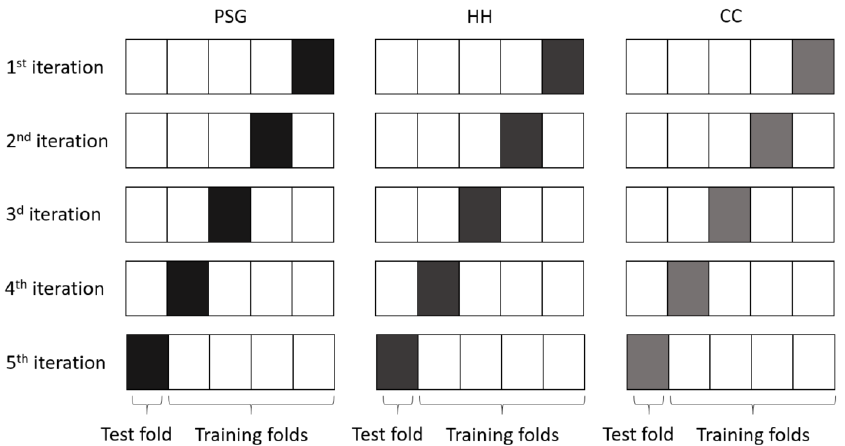
Figure 4. We tested the base classifiers using 5-fold cross-validation. Additionally, each base classifiers was also tested on all folds of the other datasets. This results in a total of 25 performance